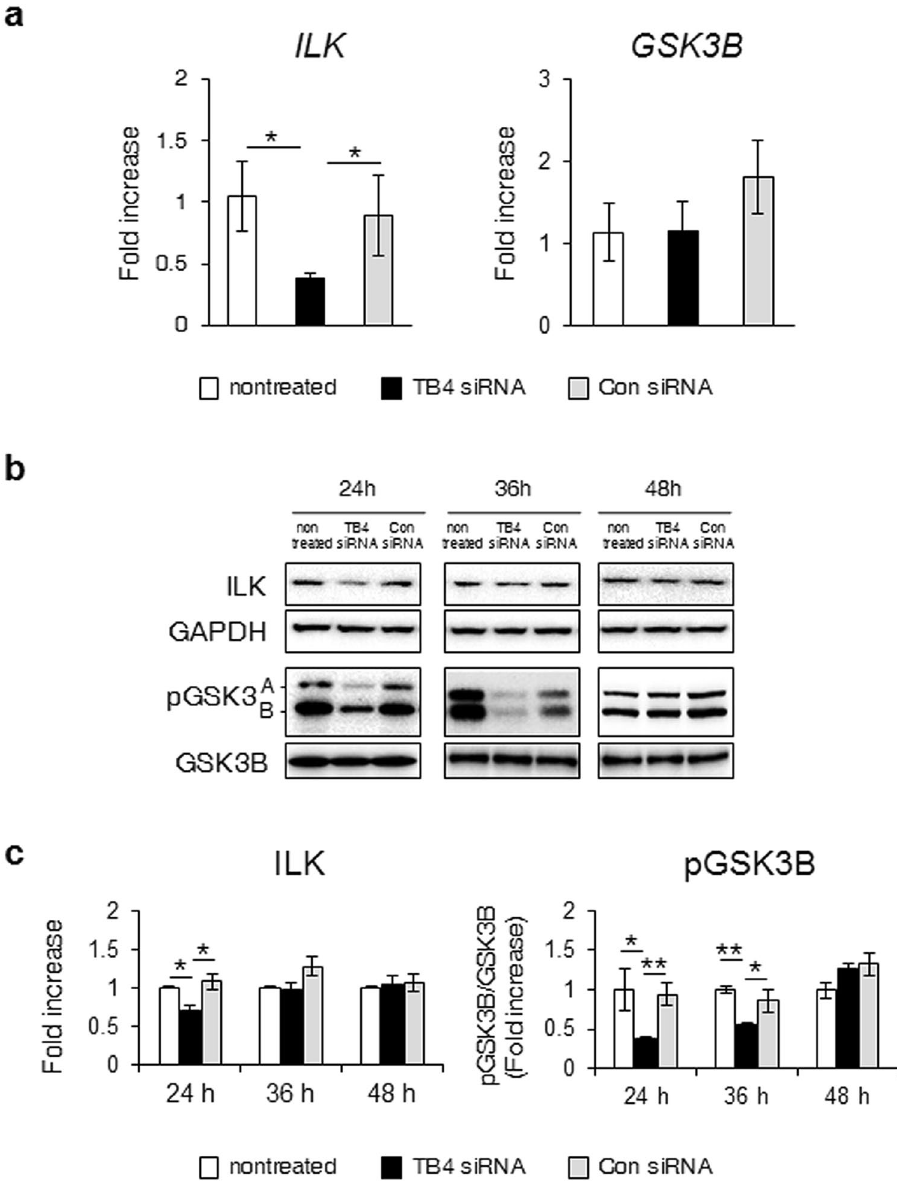
Figure 4. Deficient TB4 blocks expression of ILK and pGSK3B. ( a ) qRT-PCR of ILK and GSK3B in Con siRNA-, TB4 siRNA- or nontreated LX-2 cells at 24 hours post transfection. Results of relative expression values are shown as mean ± s.e.m. of triplicate experiments ( * p < 0.05; ** p < 0.005). ( b , c ) Protein expression of ILK, pGSK3B and GSK3B in these cells (GAPDH was used as an internal control). Data shown represent one of three experiments with similar results and the mean ± s.e.m. results obtained from three repetitive experiments are graphed ( b: Immunoblot, ( c: Band